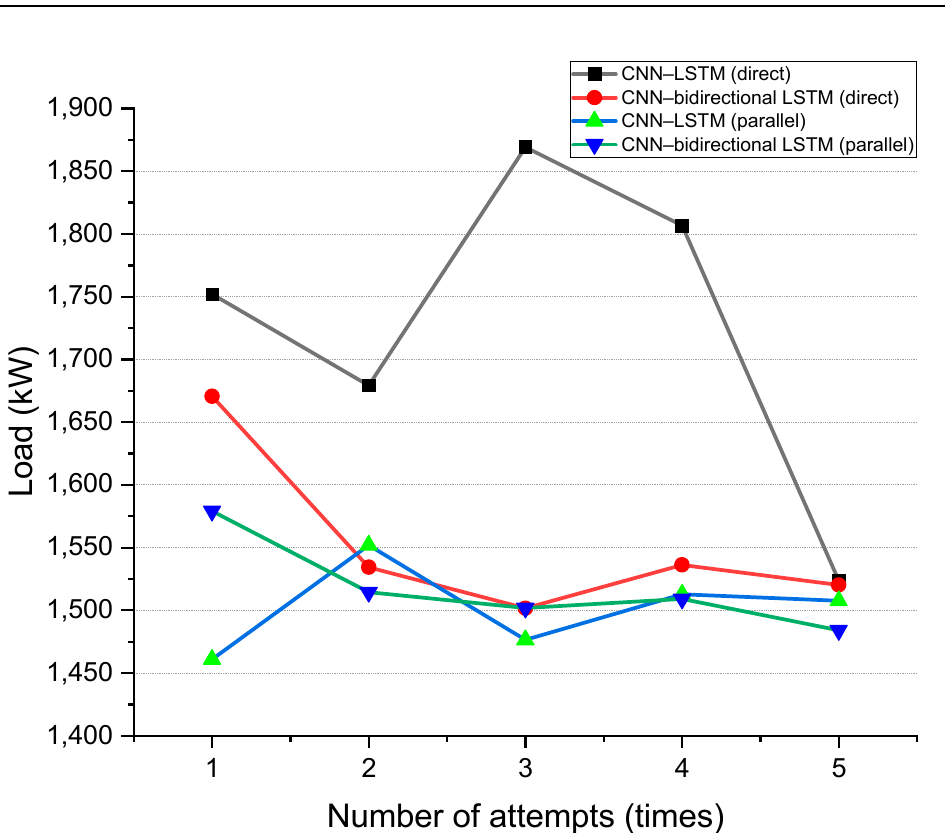
Figure 10. Comparison of RMSE values for different models.